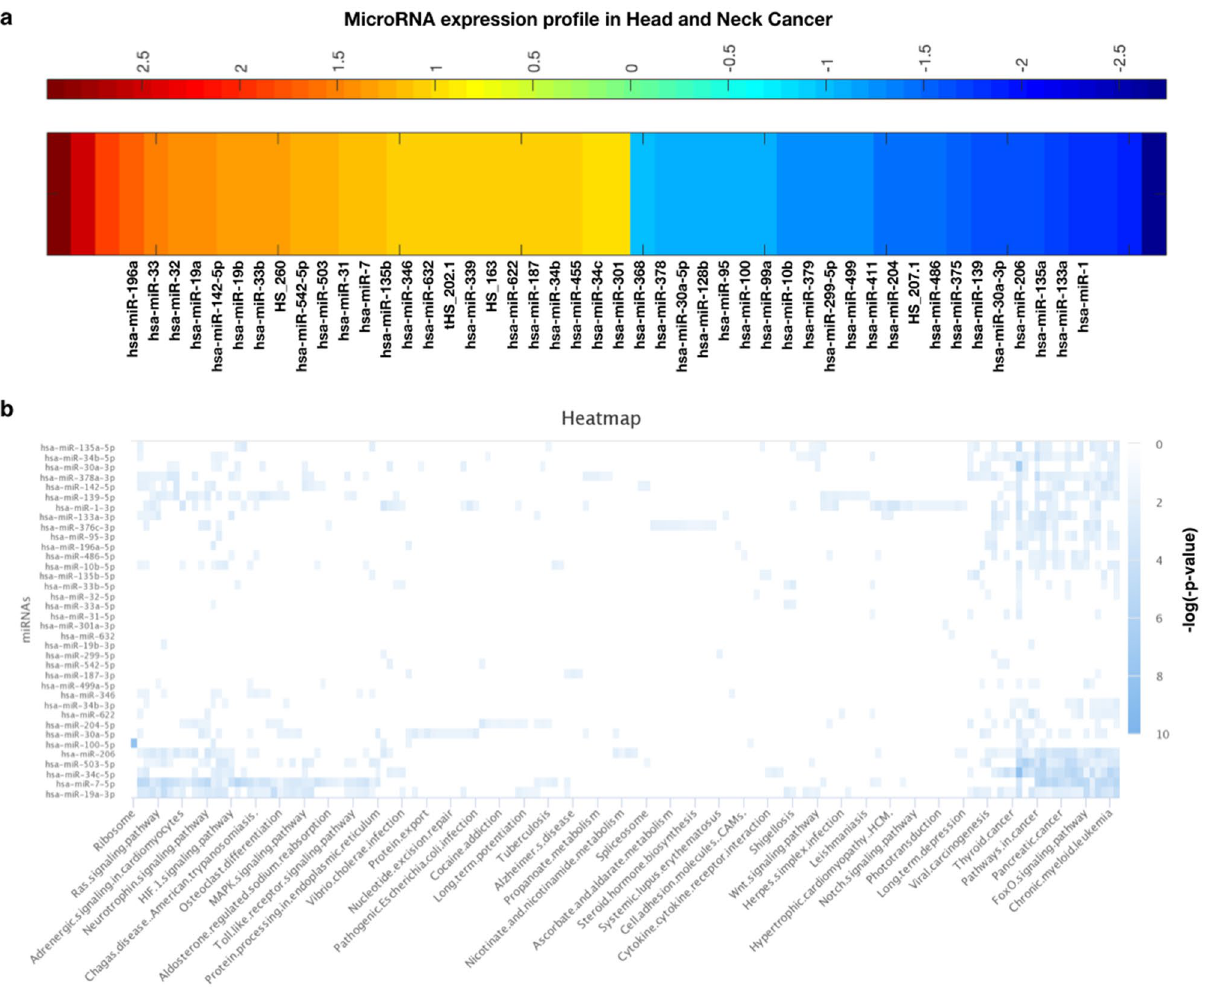
Figure 5. miRNA expression profiling and their functional impact in head and neck cancer. ( a ) Differentially expressed miRNAs and ( b ) the enriched pathways with the respective